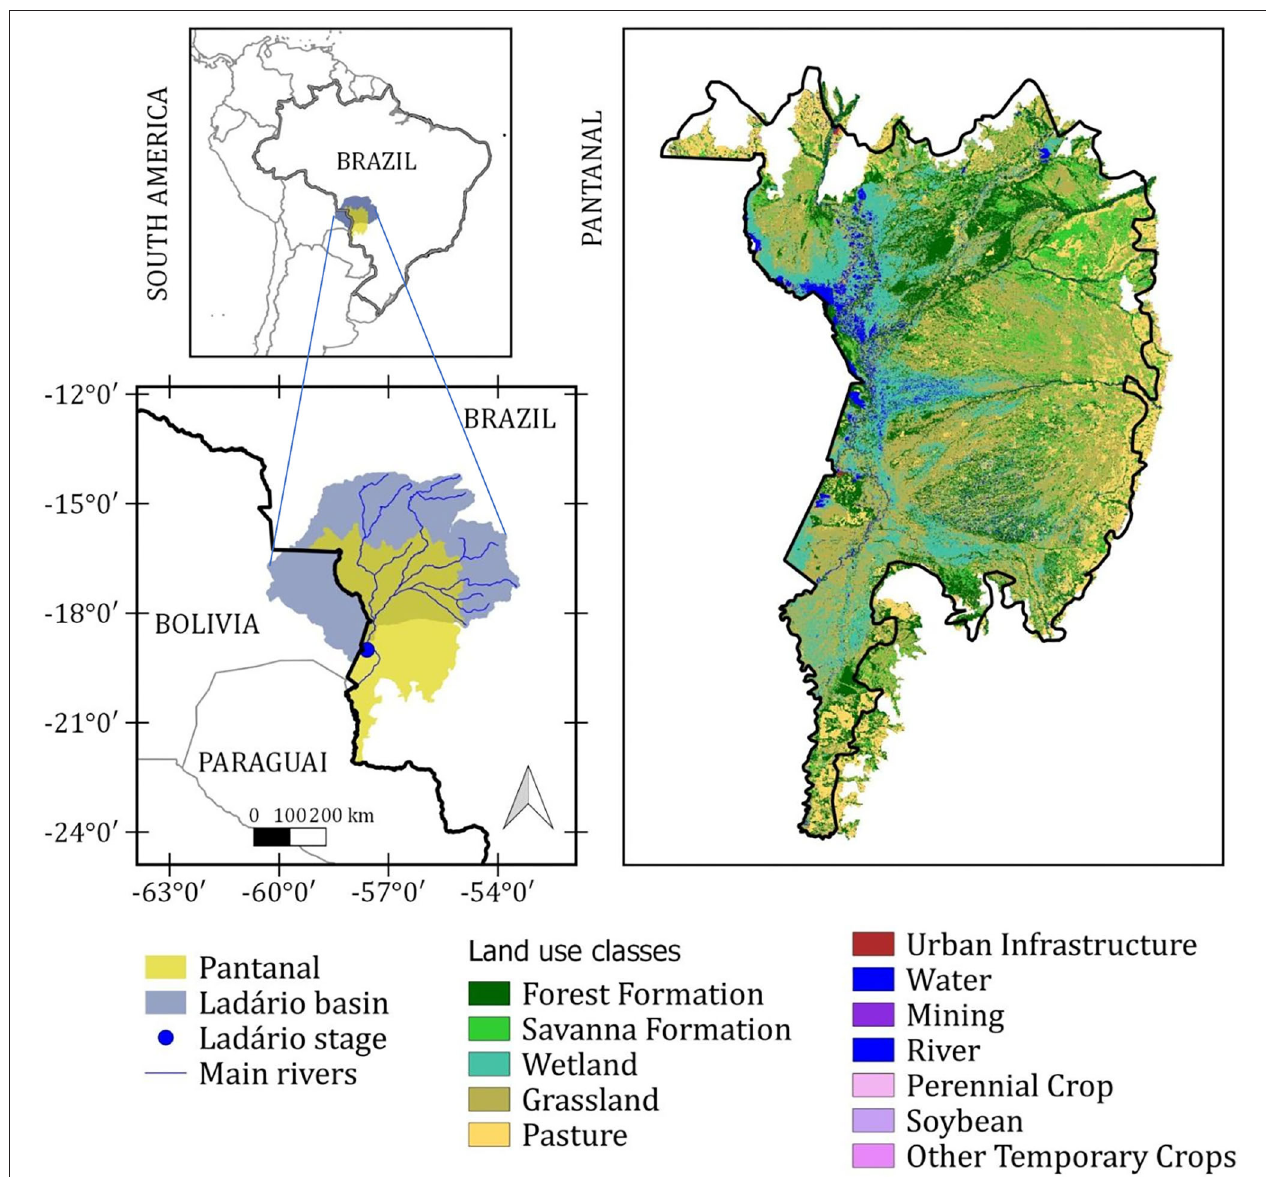
FIGURE 1 | Geographical location of the Brazilian Pantanal. The map on the right shows land use classes, and on the left the map shows the Brazilian Pantanal in yellow, the Upper-Paraguay River basin in gray, and the location of the Ladário gauge station with a blue